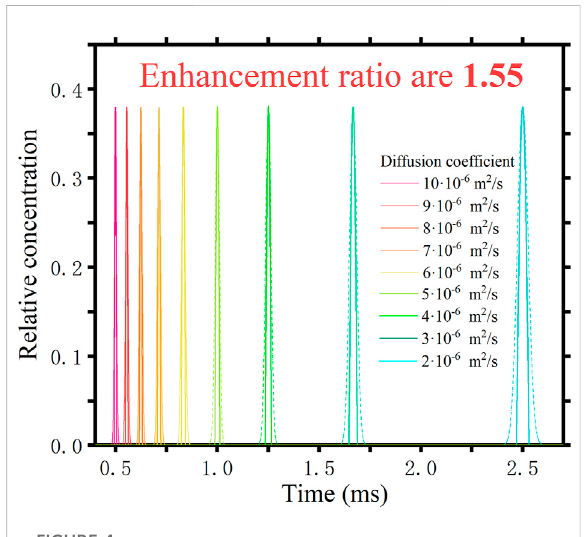
FIGURE 4 Spectra obtained using two methods for ions with different diffusion coef fi